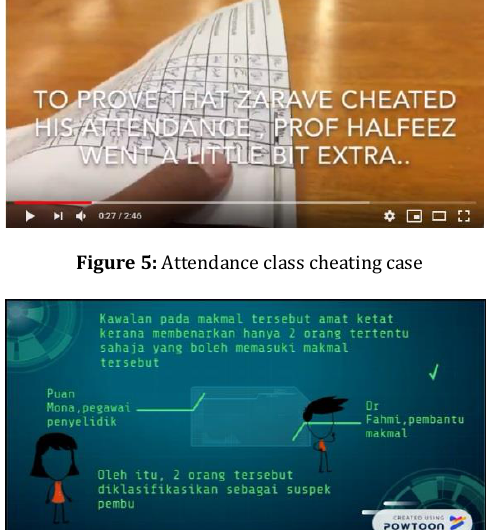
Figure 6: Professor Kassim murder case